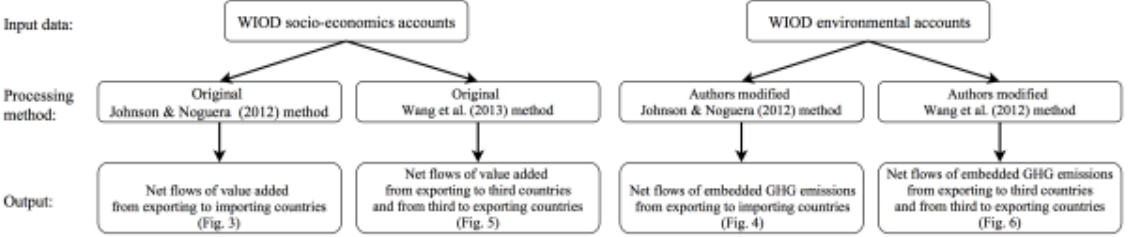
Fig. A2.1. Steps analysing the WIOD